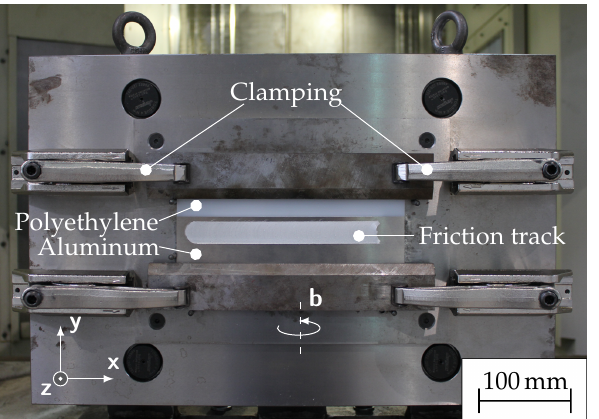
Figure 3. Customized clamping system for joining aluminum and thermoplastic material (in this case polyethylene) by friction press joining